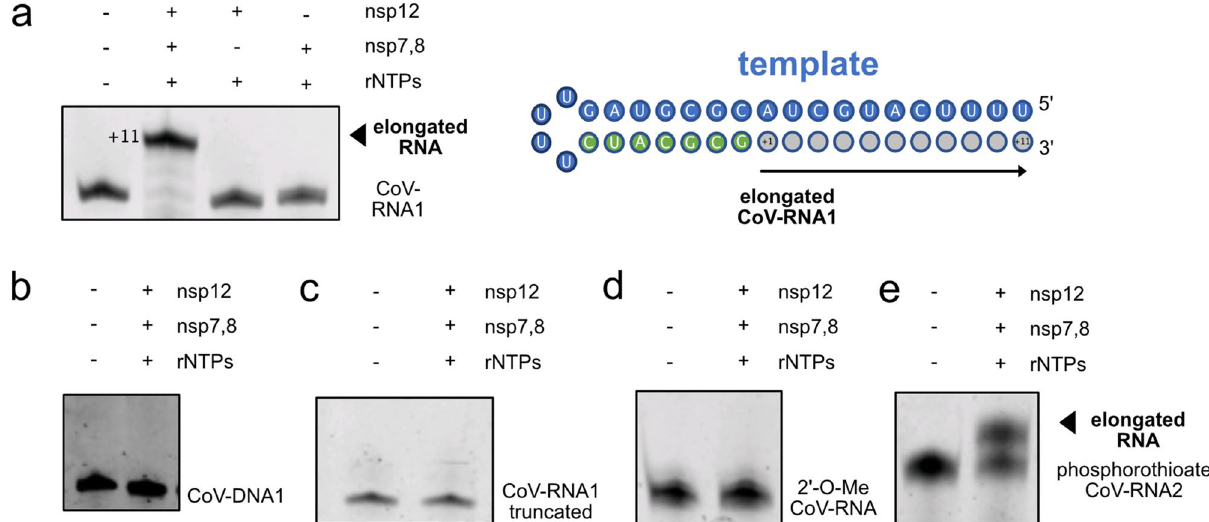
Figure 2. RdRp elongation activity is dependent on the functional group at the 2 ′ position of the ribose. ( a ) The CoV-RNA1 substrate is extended by nsp7,8,12 in the presence of rNTPs, but not by the nsp7,8 protein–protein complex, or nsp12 alone. Nsp7,8,12 does not elongate the ( b ) CoV-DNA1, ( c ) CoV-RNA1-trunctated, and ( d ) 2 ′ O-Me CoV-RNA2 substrates, respectively. ( e ) Nsp7,8,12 inefficiently elongates the phosphorothioate CoV- RNA2 substrate in the presence of rNTPs.